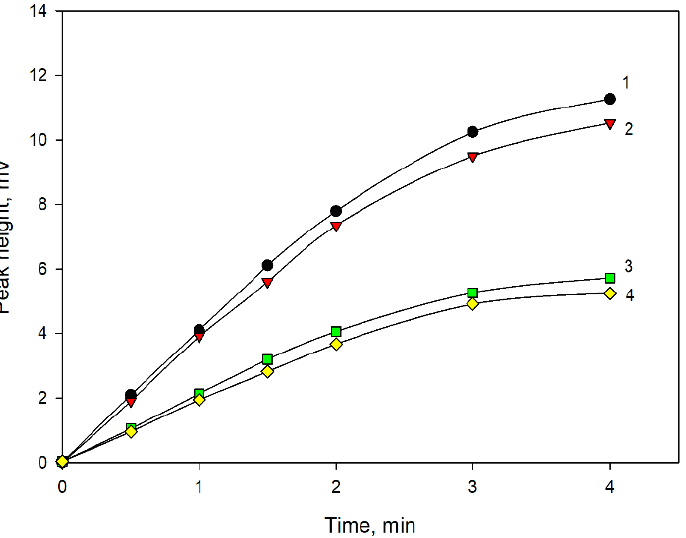
Figure 2. Dependencies of peak heights of toluene (1, 3) and benzene (2, 4) in dynamic HSA obtained for a series of model solutions at flow rates of 15 mL/min (3, 4) and 30 mL/min (1, 2). proportional to the passage time of carbon dioxide within the first two minutes. Then, the growth slowed down and practically stopped after 3 min. The increase in the slowing down